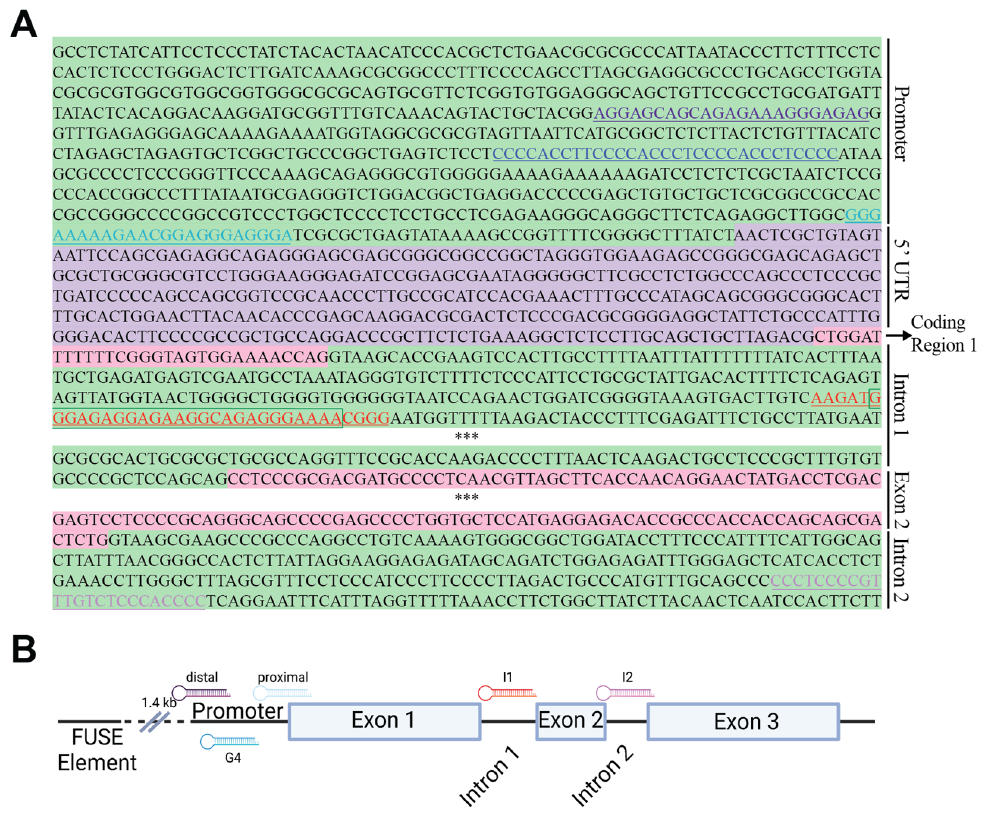
Figure 1. MYC sequence and PPRH localization. ( A ) The MYC sequence, including non-coding (green highlight) promoter and intron regions and coding (pink highlight) exons, is the target of the six designed PPRH moieties—three within the promoter region (HpMYC-PR-Distal-T, purple text; HpMYC-G4-PR-C, dark blue text; and HpMYC-PR-Prox-T, light blue text), two targeting intron 1 (HpMYC-I1-T, red text and HpMYC-I1_short-T, green box around subset of red text) and one in intron 2 (HpMYC-I2-C, lilac text). Asterisks indicate gaps in the sequence of MYC . A general schema of the MYC sequence and targeting PPRHs is shown in ( B ). Table 1. PPRHs and their G-rich targets. Name and sequence of the target G-rich forming sequences and their G4 forming potential, complementary to the polypyrimidine target of the PPRH against MYC. Guanines potentially involved in G4 formation are highlighted in bold and the entirety of the G-rich portion of the target sequence is flanked by square brackets in both length and sequence. G-rich PPRH Target Sequence (5 (cid:48) -3 (cid:48)